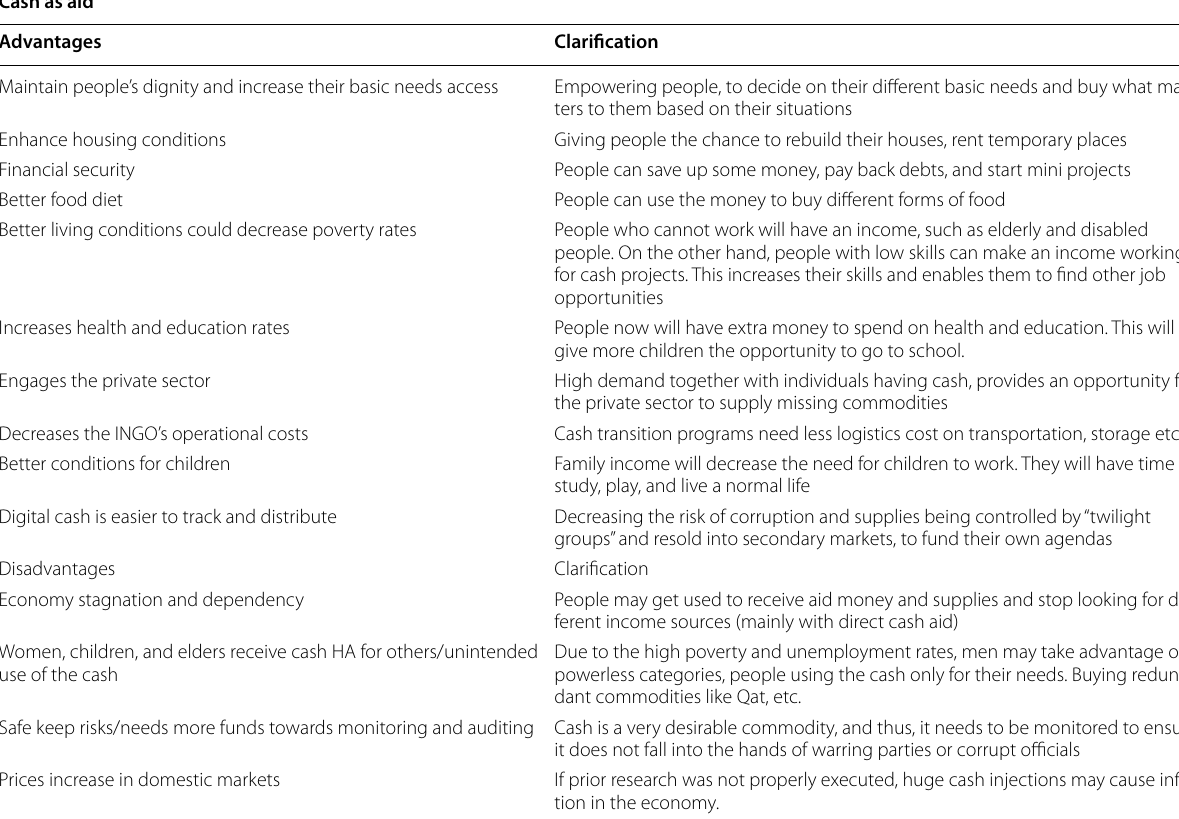
Table 1 Cash as AID advantages and disadvantages Cash as